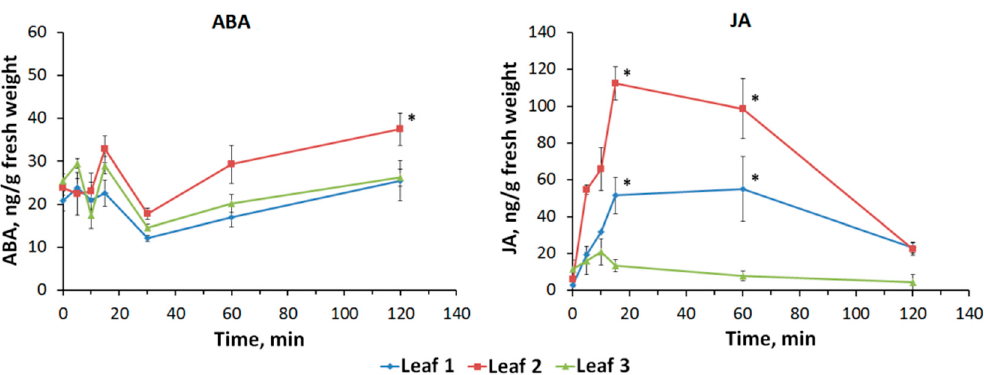
Figure 5. Time course of changes in the phytohormones abscisic acid (ABA) and jasmonic acid (JA) induced by local burning. The moment of stimulation corresponds to the point of 0 min. * indicates that difference from control value (0 min) were significant ( p < 0.05).